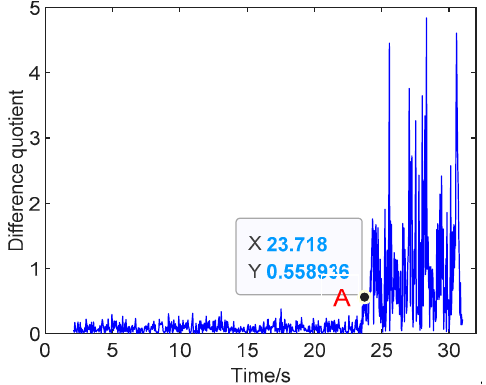
Figure 13. Difference quotient of the dynamic G-SampEn.